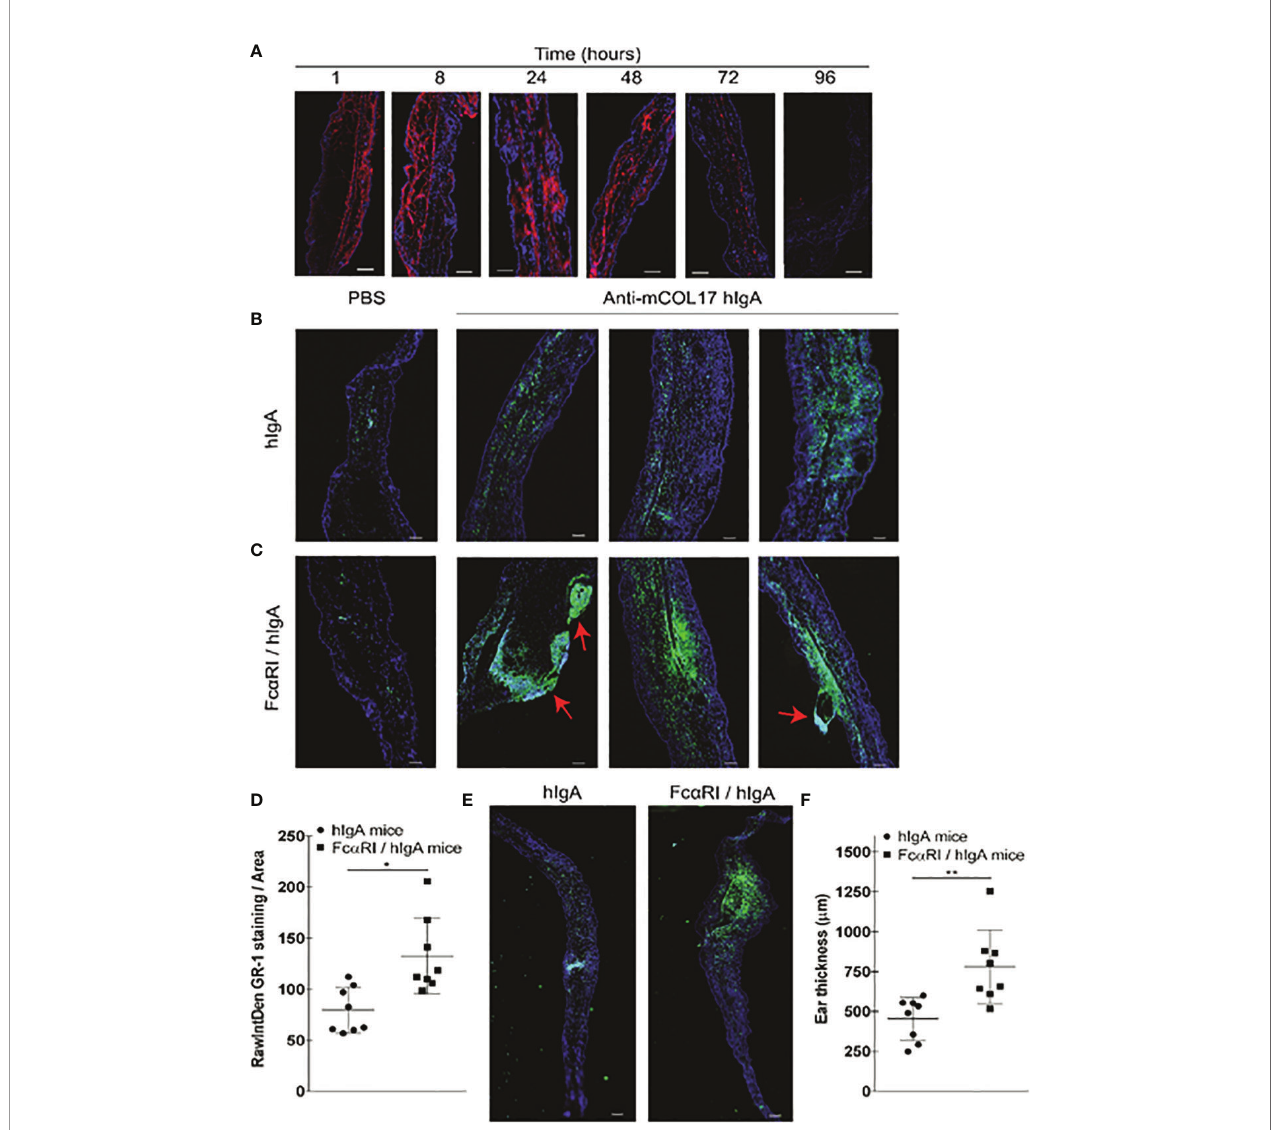
FIGURE 3 | hlgA anti-mCOL17-induced neutrophil migration and chronic in fl ammation in Fc a RI/hlgA mice. (A) Cryosections of ears of Fc a RI/hlgA mice were stained with anti-human lgA (red) and DAPl (DNA; blue) after injection of anti-mCOL17 hlgA antibodies. Mice were sacri fi ced at indicated time points. Scale bars: 75 m m. (B, C) hlgA (B) and FcRI/hlgA (C) mice were injected with PBS (left panel) or anti-mCOL17 hlgA (right panels) every other day till sacri fi ce on day 7 (in total 4 injections). Cryosections were stained with the neutrophil marker GR-1 (green) and DAPl (DNA; blue). 3 representative examples are shown. Red arrowheads indicate blister formation and tissue damage. Scale bars: 100 m m. (D) Quanti fi cation of GR-1 staining. Each dot represents one mouse. N = 8 per group (E, F) Analysis of ear thickness. (E) A representative cryosection example of a hlgA mouse ear (left panel) or Fc a RI/hlgA mouse ear (right panel) are shown. Scale bars: 250 m m. (F) Quanti fi cation of ear thickness. N = 8; each dot represents one mouse. Data are presented as mean ± SD. Student ’ s t test; *p < 0.05, **p <